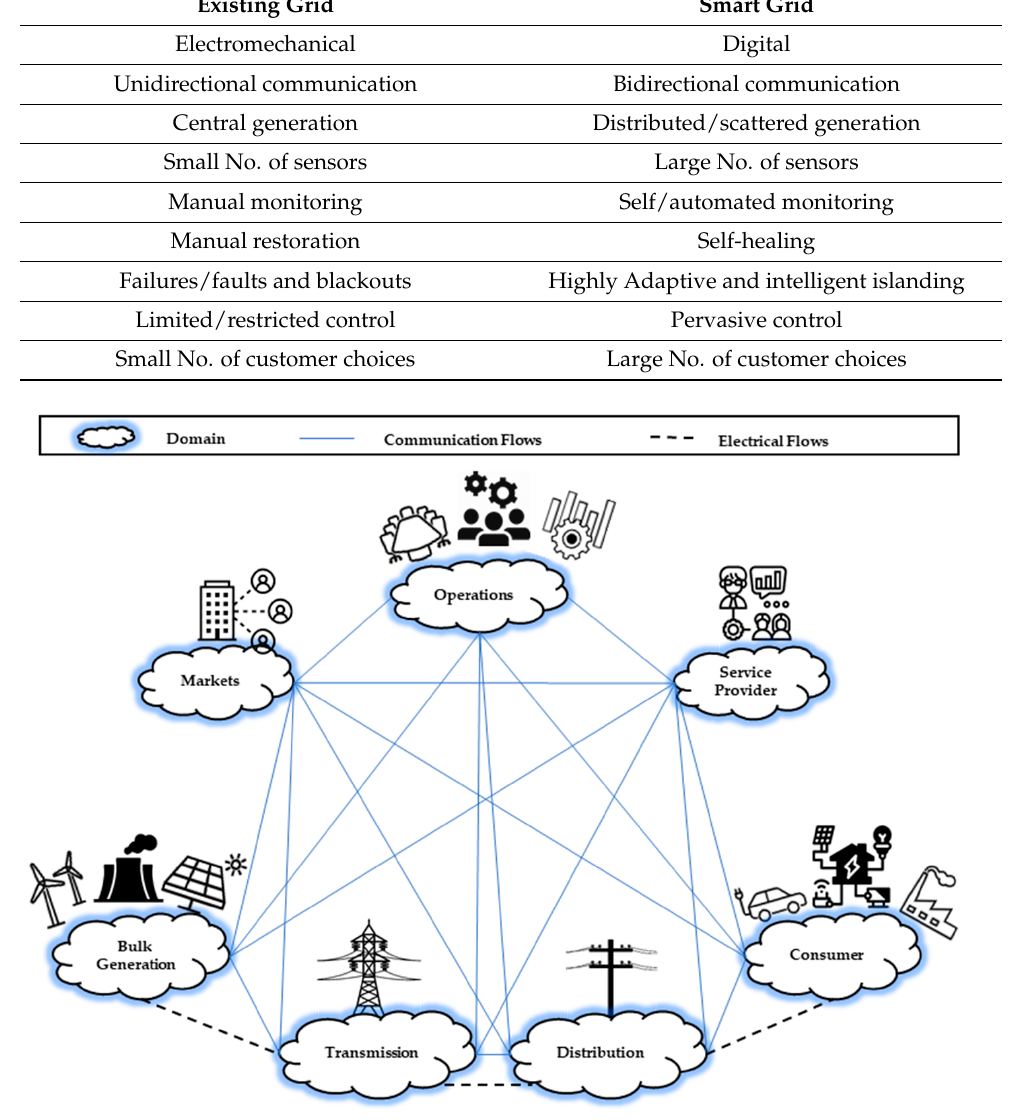
Figure 2. NIST Model for SG .